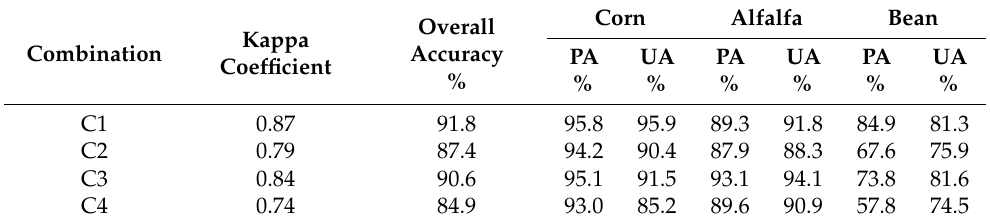
Table 8. Accuracy assessment obtained for each of the crop recognition models with the BT algorithm.